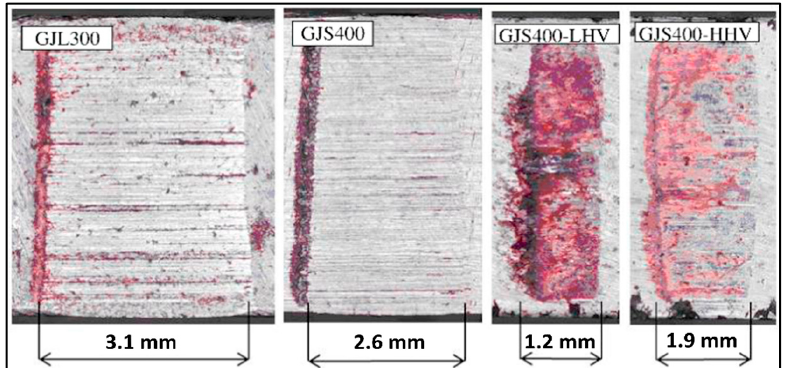
Figure 18. Worn surfaces of different cast irons for a 20 N applied load (Reprinted with permission from ref. [70]. 2016 Elsevier).